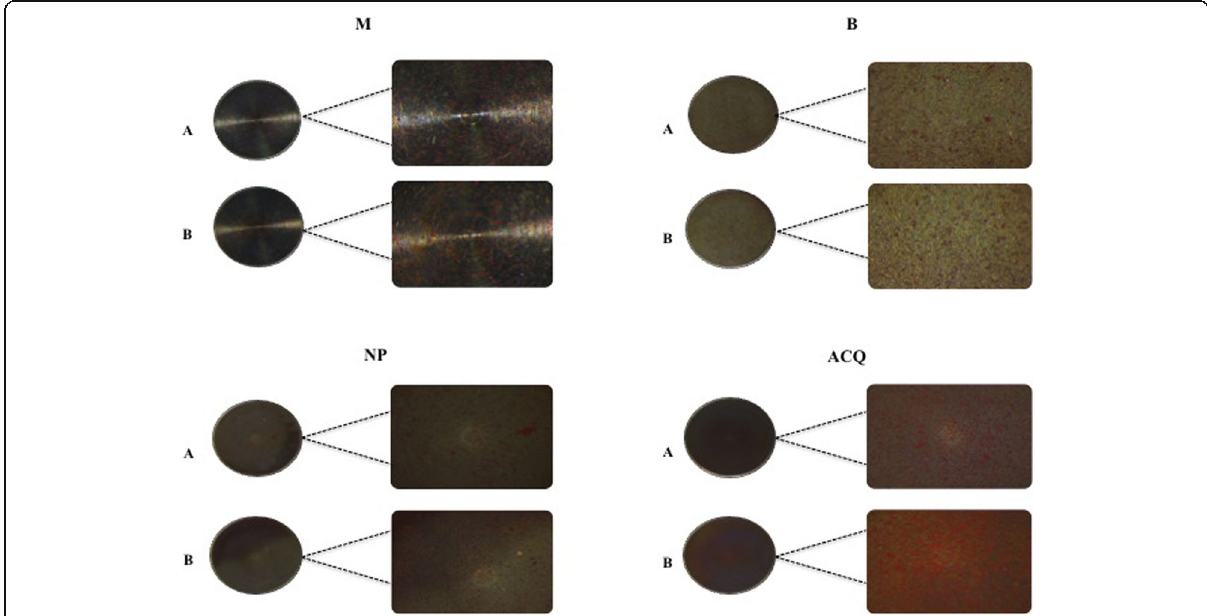
Fig. 6 Mineralization activity of SC-EHAD cells at 14 days in the different groups. a Standard medium. b Osteogenic medium. *Squared images represent ¼ of disk surface